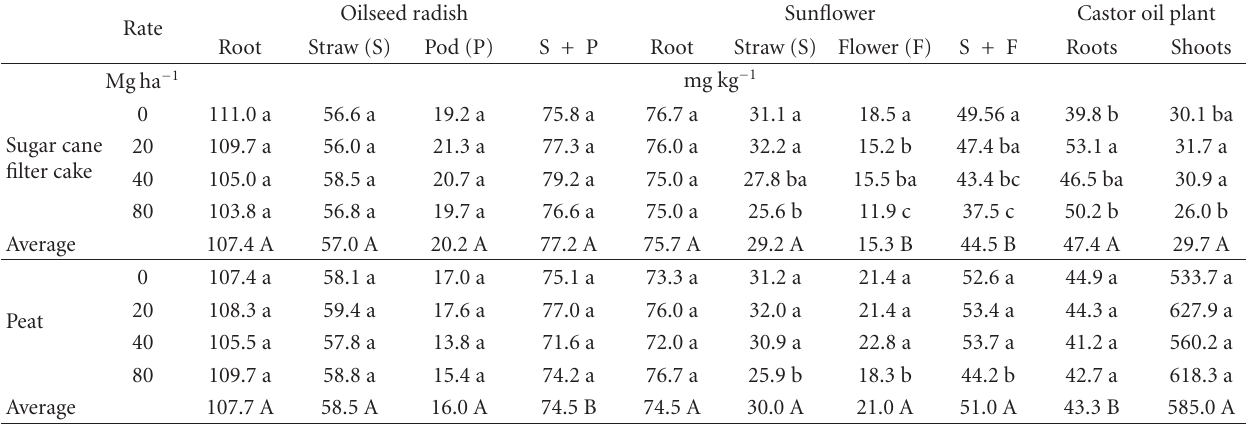
Table 3: Barium in plant parts of the tested species according to the rate of organic material treatment ∗ . Rate